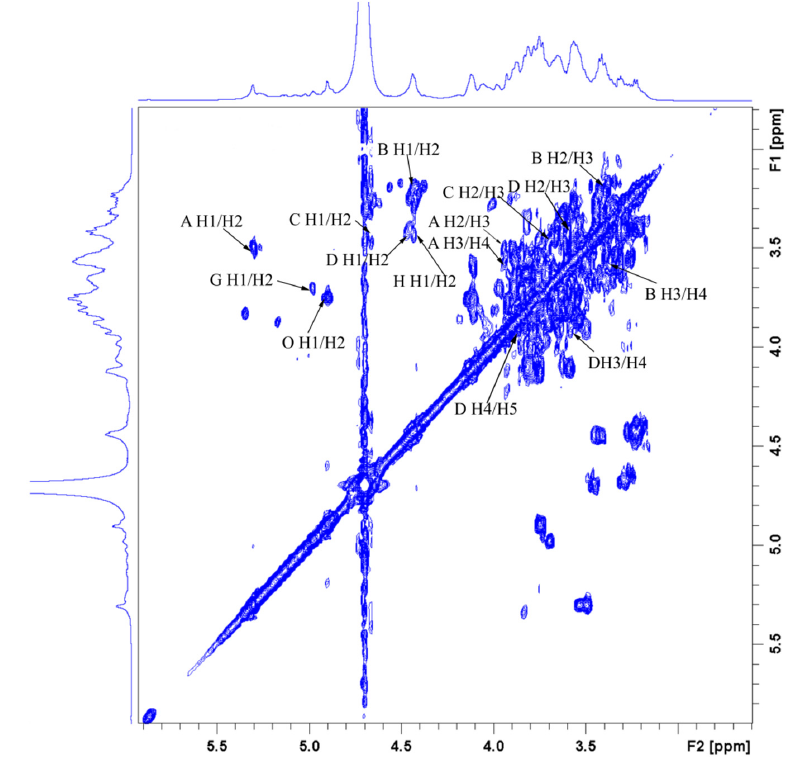
Figure 9. 1 H- 1 H COSY spectrum of GLP-1.